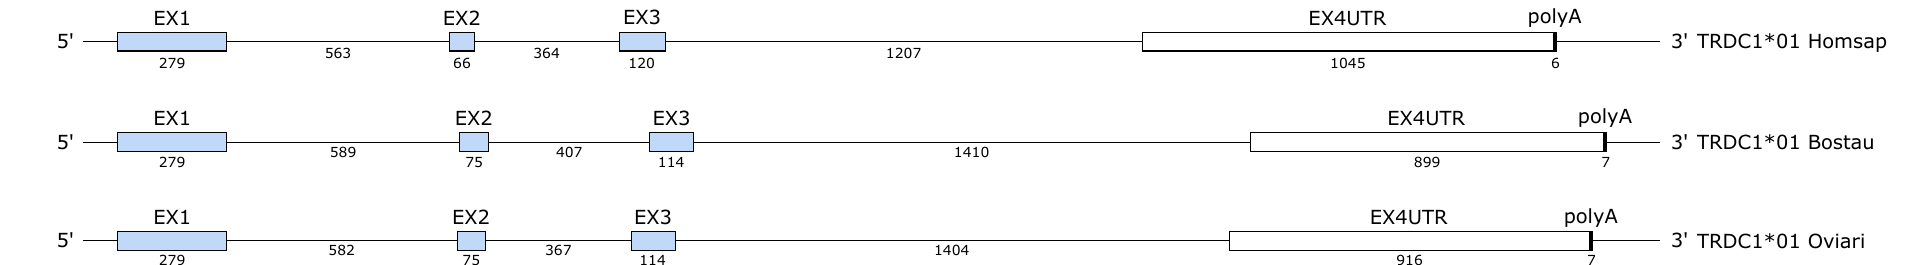
Figure 3. Structure of the TRDC genes in human (Homsap), bovine (Bostau) and sheep (Oviari). The numbers correspond to the size of the exons and introns in nucleotides.